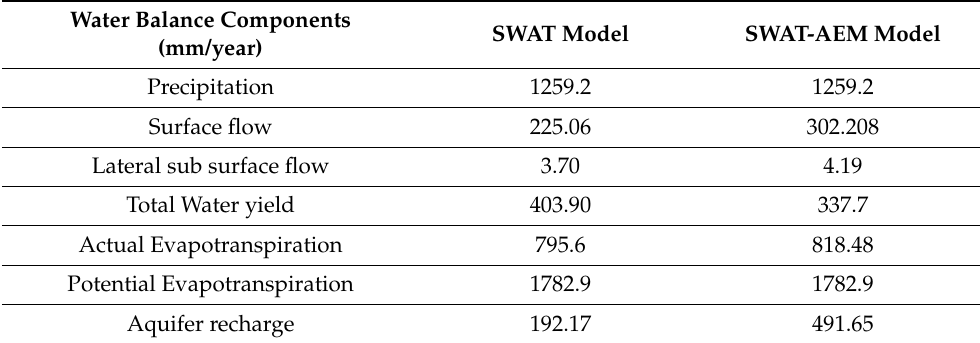
Table 5. Average annual result summary of water balance components for San Jacinto river basin during the study period (2003–2017) simulated by SWAT and SWAT-AEM